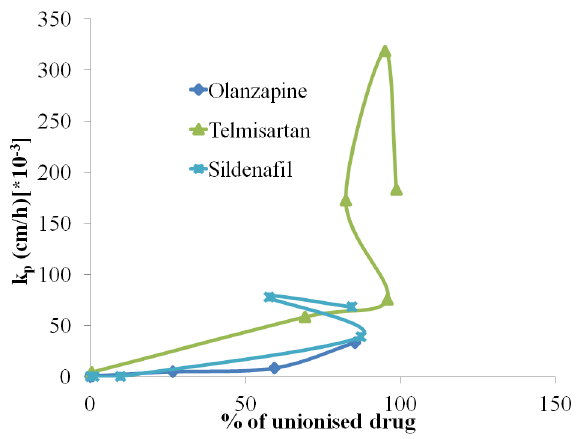
FIGURE 4 - Solubility vs. Kp of weakly basic drugs.